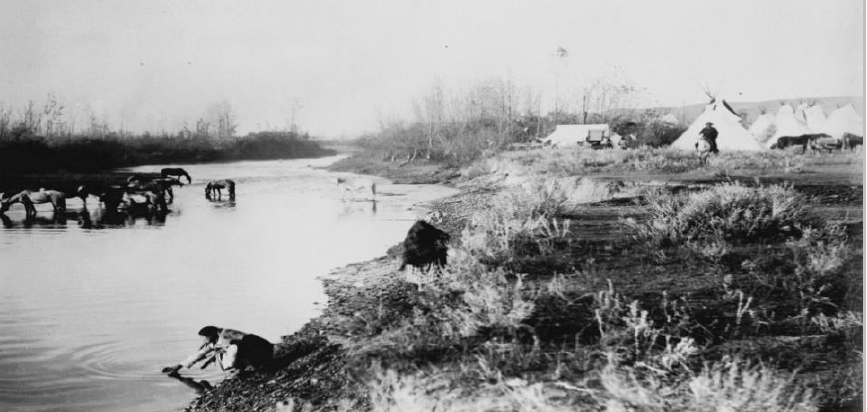
Figure 4. A Crow woman collecting water from the Little Bighorn River, Crow Agency, MT. This was the main water source for the Crow people before the 1960s. (Photo used with permission from The Crow Indians Photographic College Archives, Crow Agency, Montana. Original at American Anthropological Archives, Washington, DC, USA).